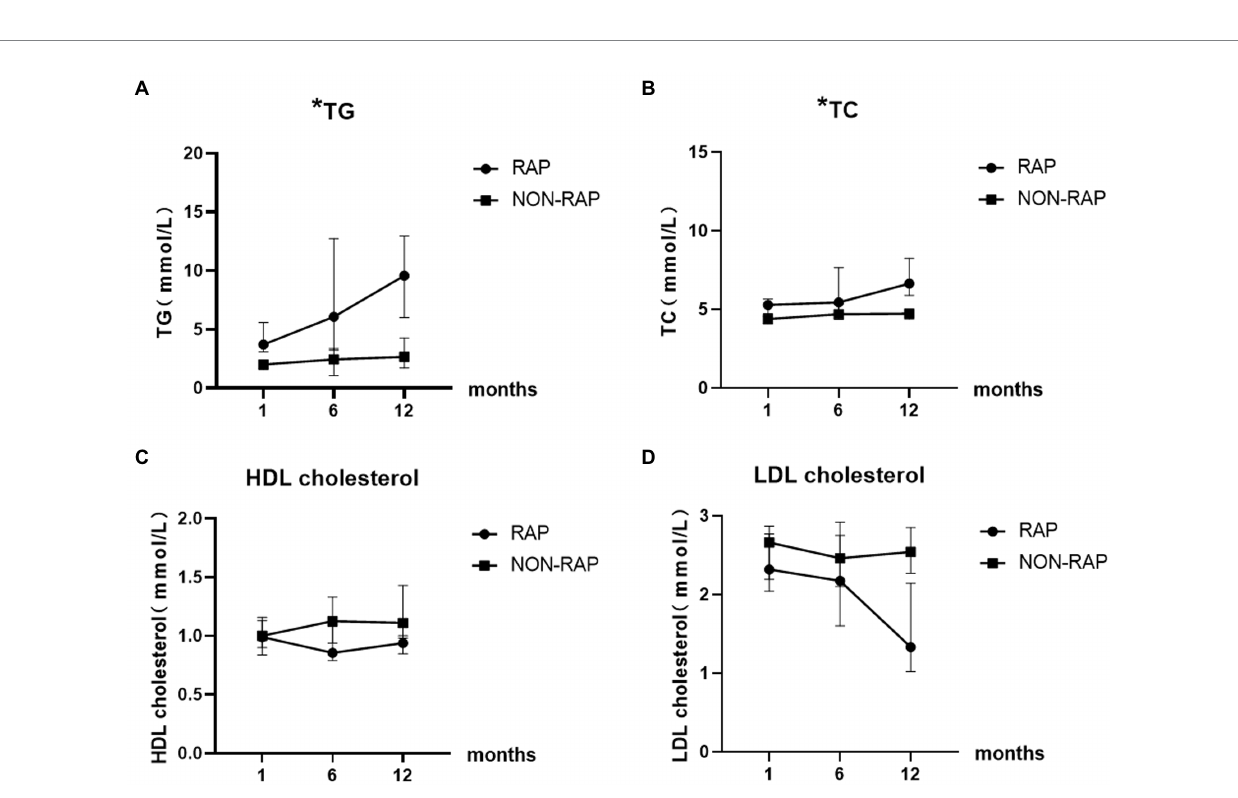
FIGURE 3 Dynamic change of serum lipid levels of patients with HTGP during follow-up, (A) the serum TG levels, (B) the serum TC levels, (C) the serum HDL cholesterol levels, (D) the serum LDL cholesterol levels. * indicates statistically significant difference.